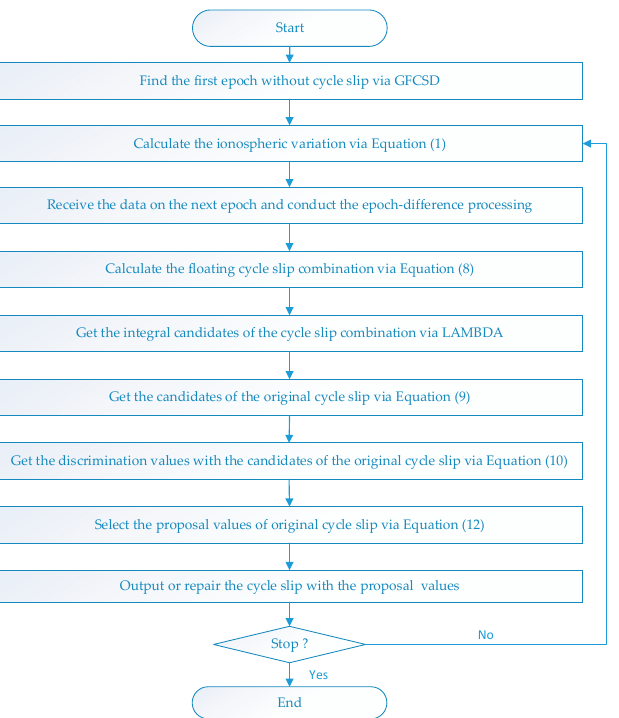
Figure 1. The process flow of the GPS triple-frequency cycle slip repair (CSR) method (GTCSR).